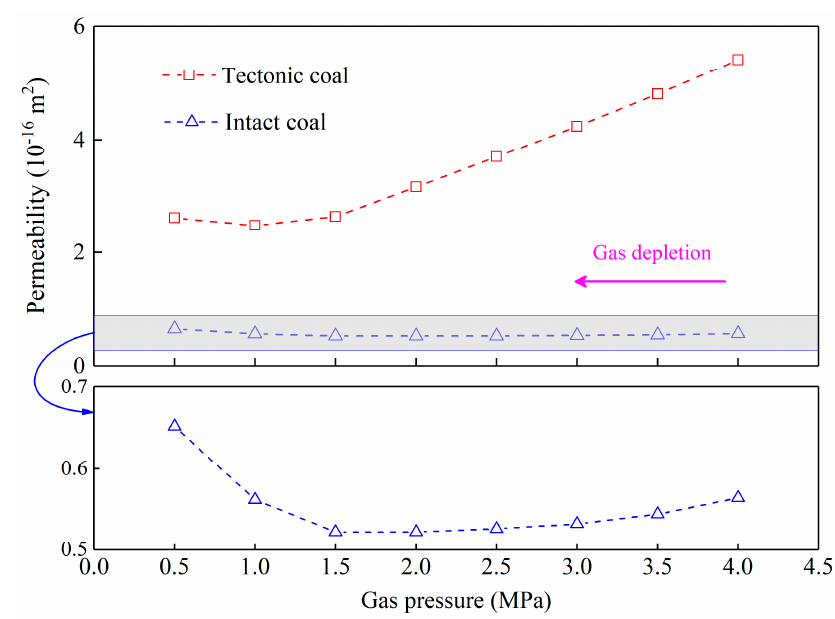
Figure 6. The evolution of coal permeability during gas depletion.